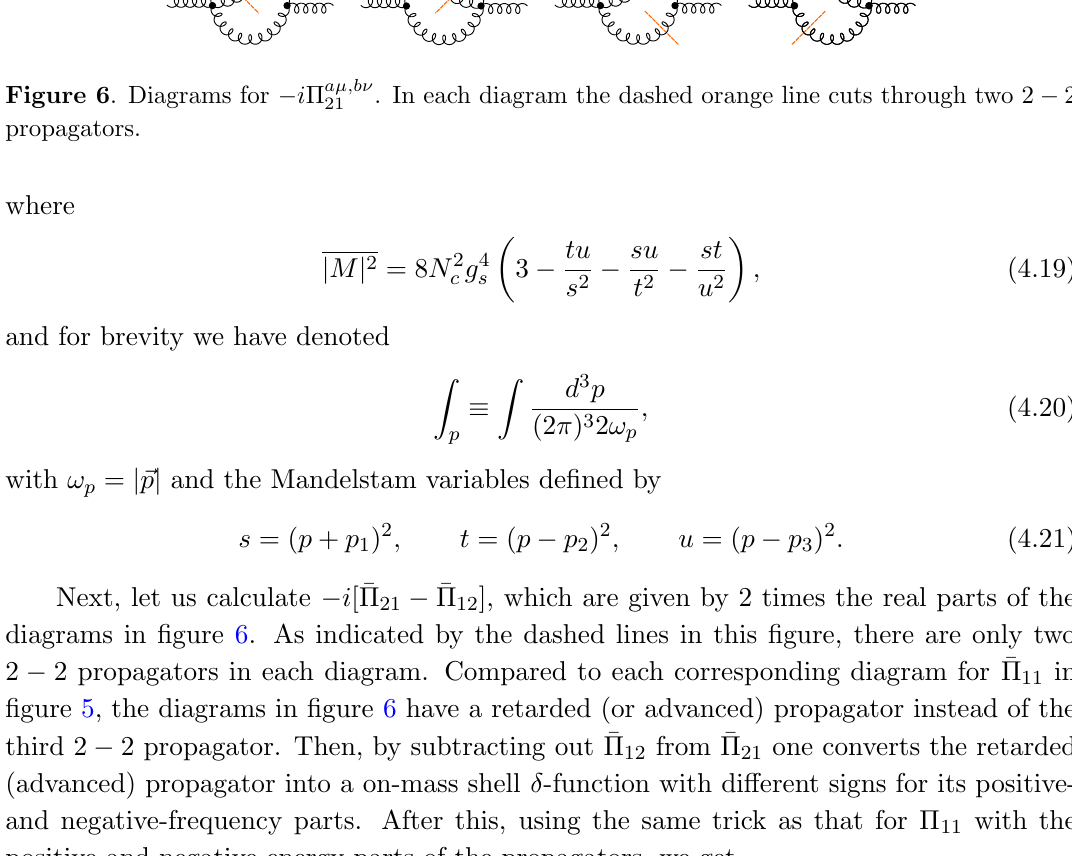
Figure 6 . Diagrams for (cid:0) i (cid:5) a(cid:22);b(cid:23)